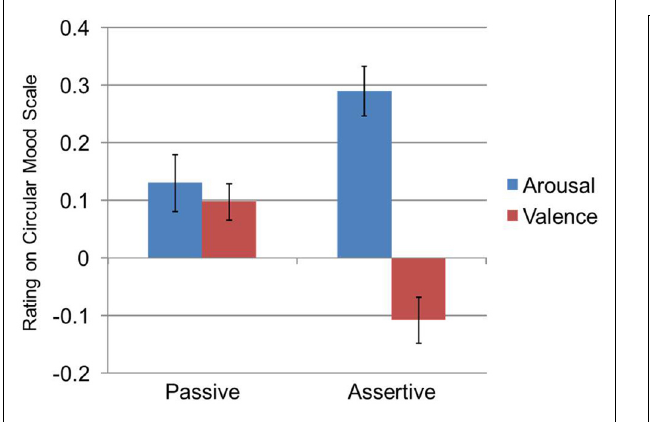
FIGURE 5 | Interaction between proxemic behavior condition and the dimensions of mood as measured by the CMS.